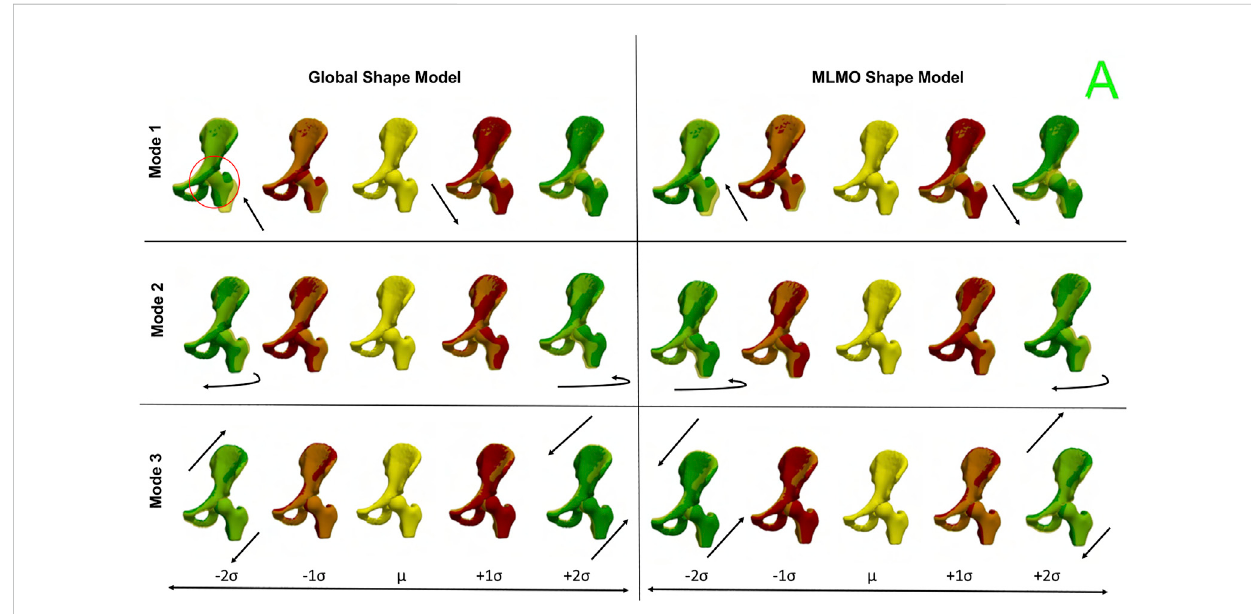
FIGURE 12 Between-organs modes of variation showing relative pose variations for the hip joint dataset. The mean shape is yellow in color with ± 1 σ modes shown in red and ± 2 σ modes shown in green color. The arrows denote the direction along which signi fi cant pose variations take